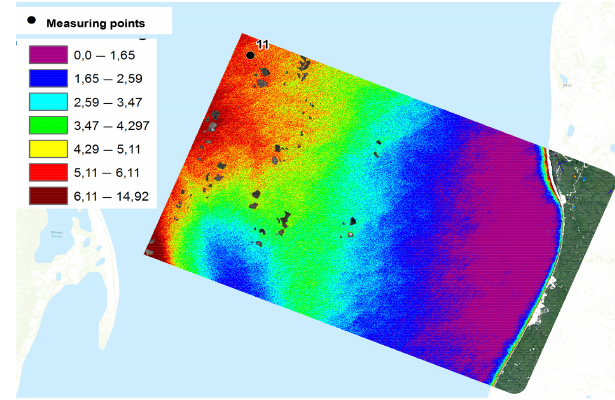
Figure 2. CHL distribution according to RapidEye data, mgm − 3 (4 August 2015).